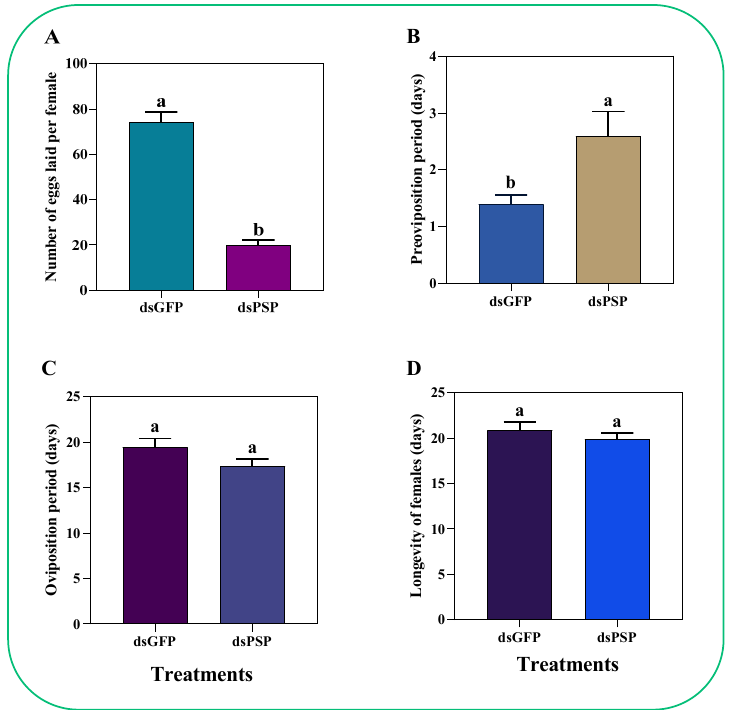
Figure 9. Knockdown of the PSP gene reduced the egg-laying capacity of individual adult females ( A ) and increased preoviposition periods ( B ), with no influence on oviposition periods ( C ) nor female